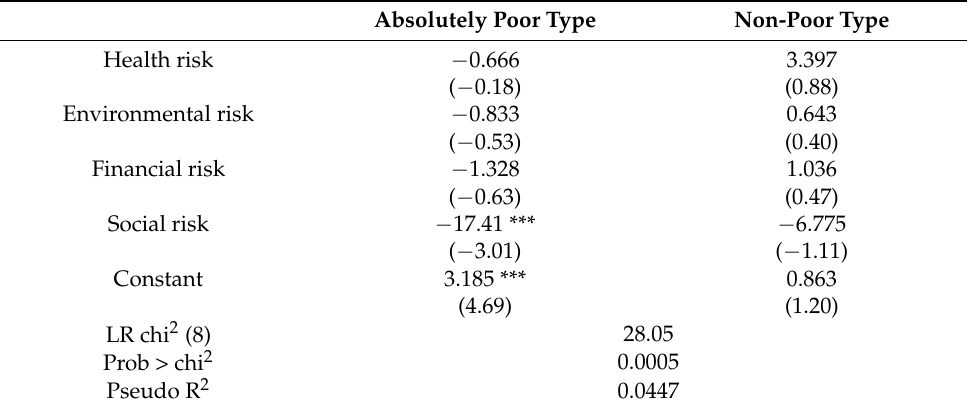
Table 4. Multinomial logistic regression results of the difference in livelihood risks faced by different types of poverty-stricken